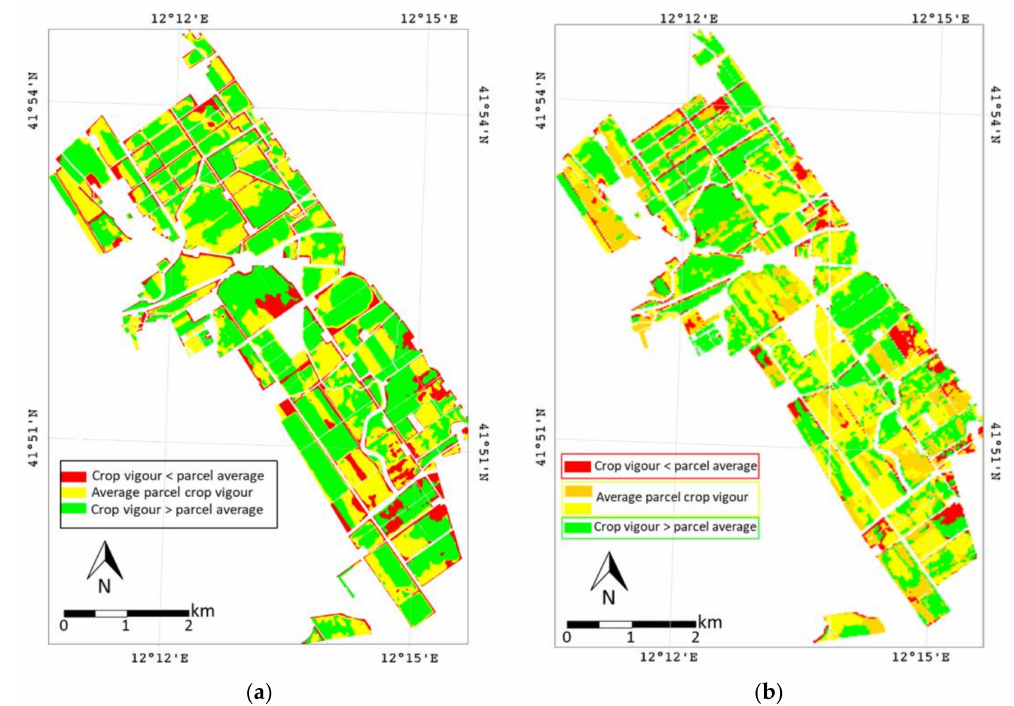
Figure 3. Clustering maps showing the results obtained at the field level by applying ( a ) standard K-means and ( b ) MFPCA. A fixed number of classes was defined a priori: three classes for ( a ) and four classes for ( b ). The red color represents pixels with crop vigor lower than the field average, yellow or orange pixels with average crop vigor, and green pixels with crop vigor higher than the field